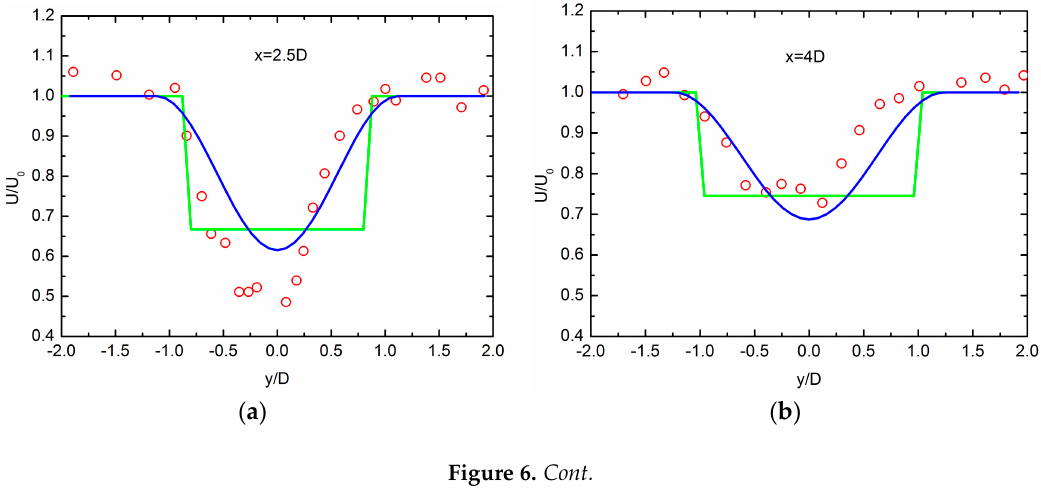
Figure 5. Contours of the wake velocity for two Nibe wind turbines. ( a ) Standard Jensen’s model; ( b ) 2D Jensen’s model.